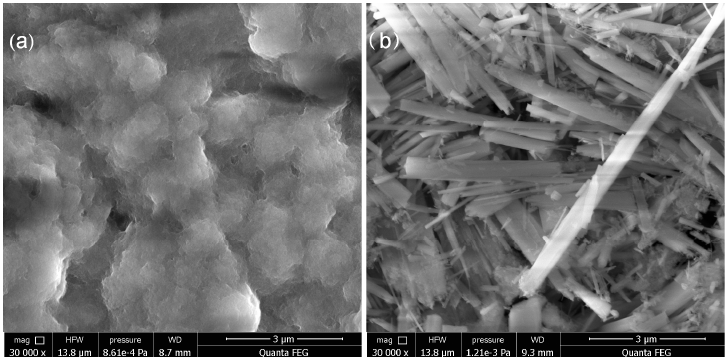
Figure 3. SEM micrographs of the systems calcined at 600 °C at the Ca/Si molar ratio: ( a ) 0.1; ( b ) 1.0.